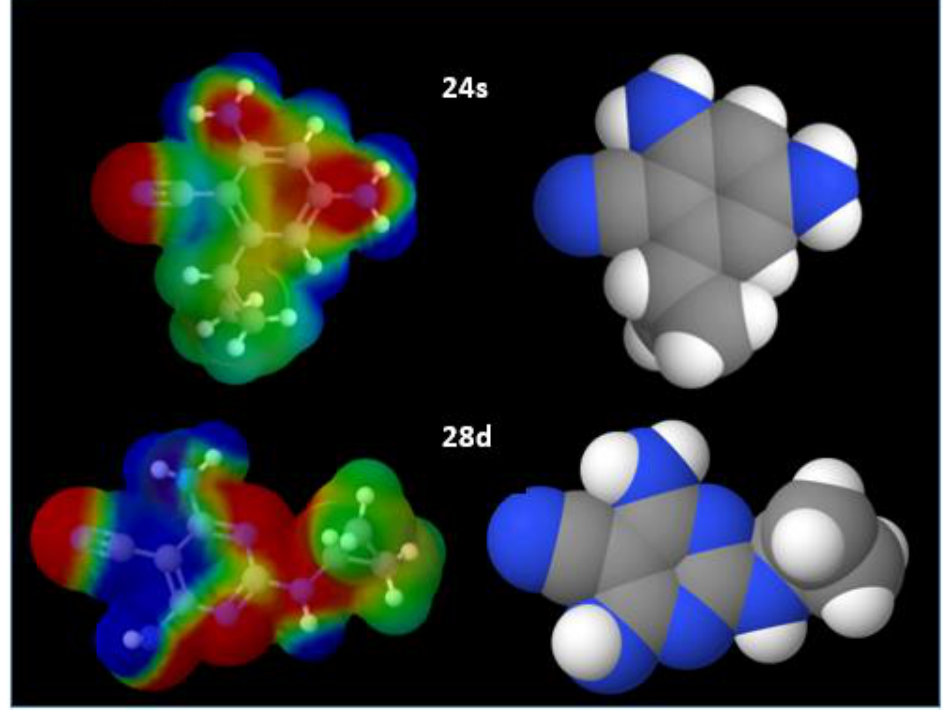
Figure 6. Compounds 24s and 28d MEP and space filling models.